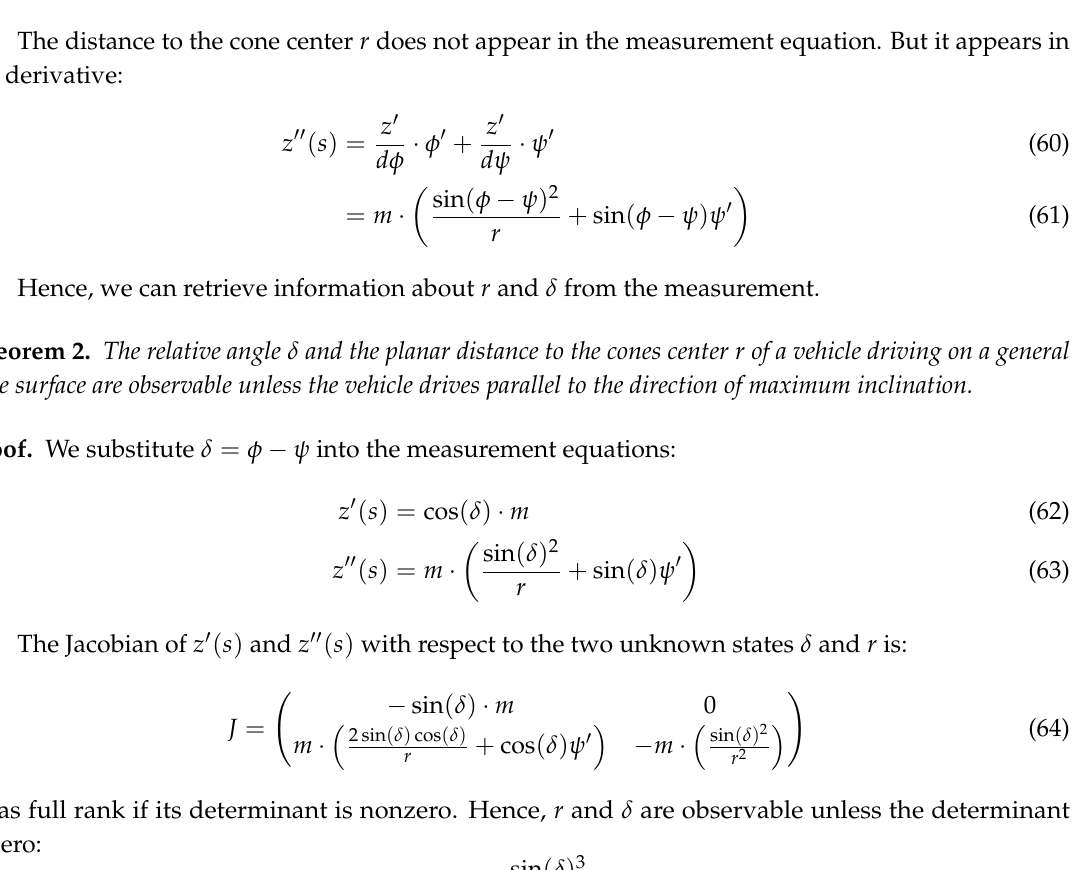
Figure 9. Cone-shaped